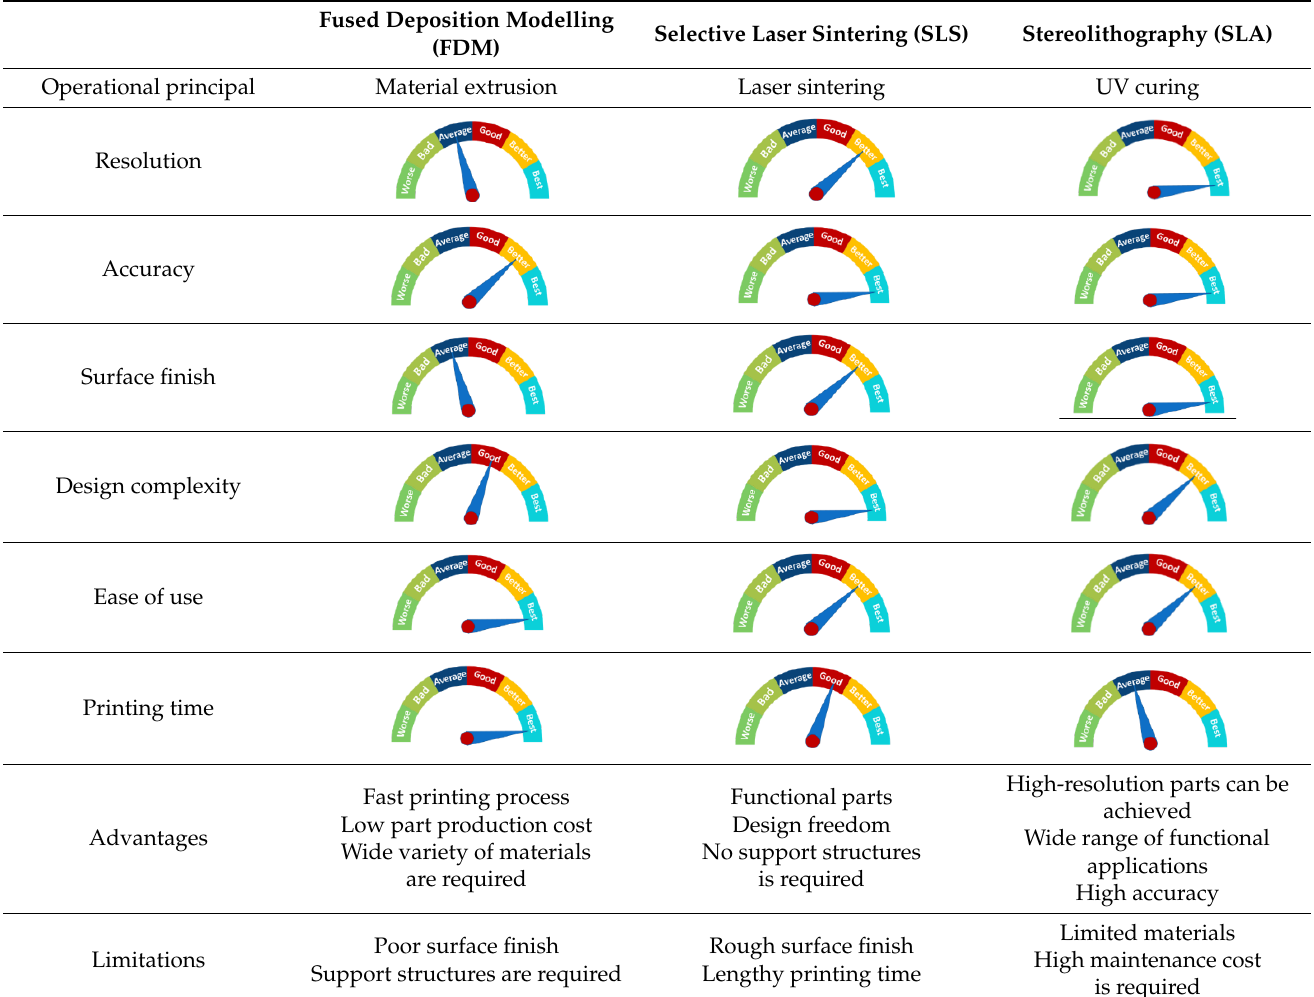
Table 7. A comparative overview of FDM, SLS, and SLA printing processes. The representation is created to provide a guideline only. Fused Deposition